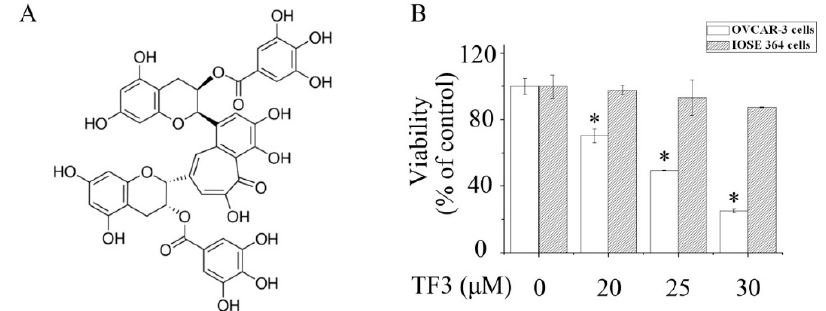
Figure 1. Theaflavin-3,3’-digallate (TF3) selectively reduced the viability of ovarian cancer cells. ( A ) Chemical structure of TF3. ( B ) The viability of human ovarian carcinoma (OVCAR-3) cells and normal human immortalized ovarian surface epithelial cells (IOSE 364) cells exposed to TF3. * p < 0.05 compared with the control group.